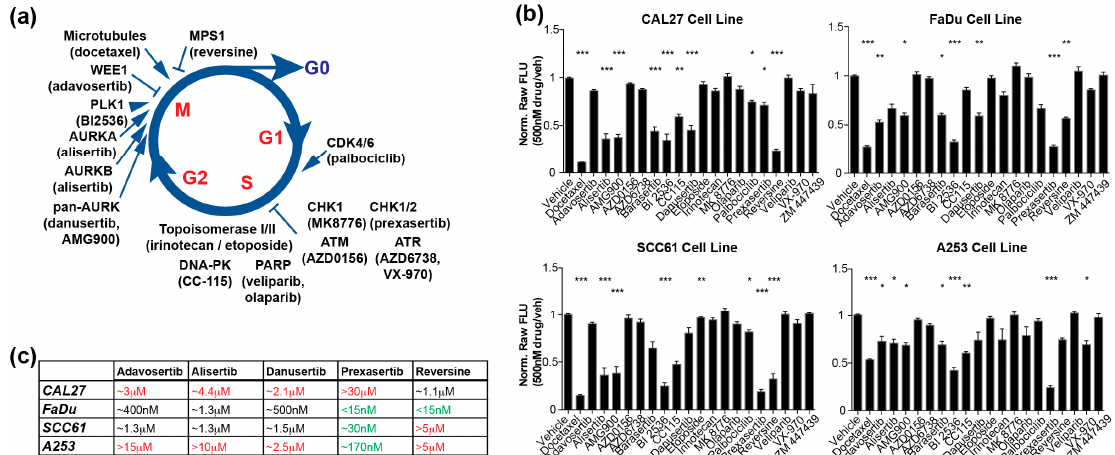
Figure 1. Initial high throughput screening results in multiple HNSCC cell lines using 24 compounds. ( a ) Schematic representation of drugs targeting proteins active in cell cycle regulation; ( b ) Cell viability determination by CellTiterBlue assay for 4 cell lines treated with drugs indicated at 500 nM concentration; ( с ) Summary of IC50 values for selected compounds for four cell lines. Greater resistance, red font; more sensitive, green font. See also Figure S1. All graphs: *, p ≤ 0.05; **, p ≤ 0.01; ***, p ≤ 0.001 relative to vehicle control.